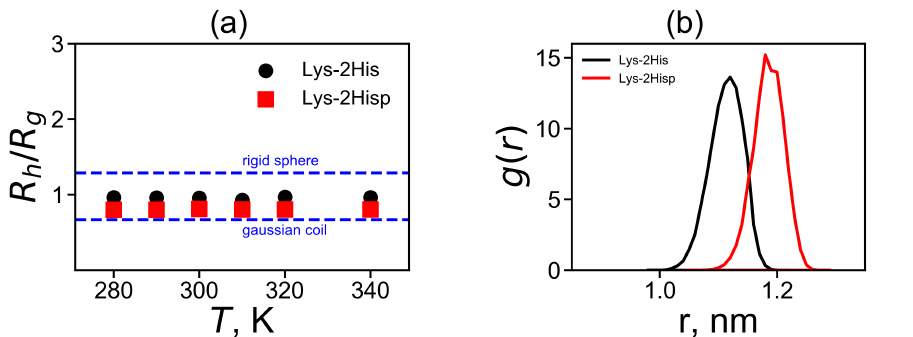
Figure 4. ( a ) The temperature dependences of the characteristic ratio R h (obtained by the Kirkwood approximation) to the radius of gyration R g and ( b ) the distribution g ( d ) of a spacer length d between the neighboring branching points of the